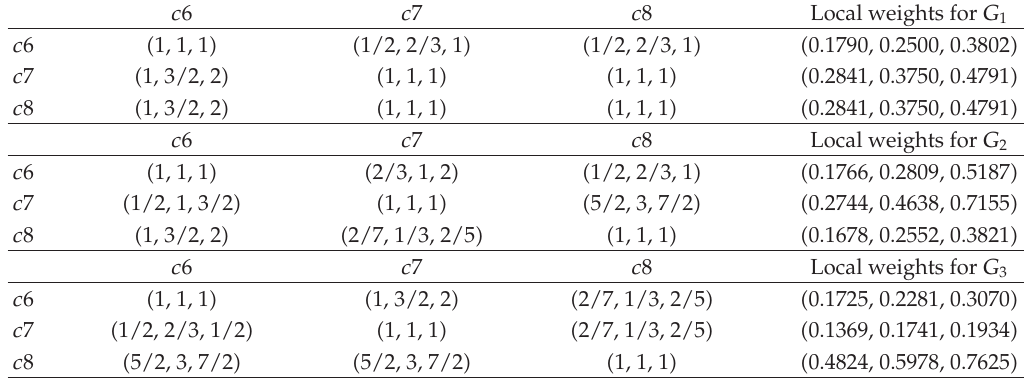
Table 6: Local weights and pairwise comparison matrix of subfactors belonging to PF.